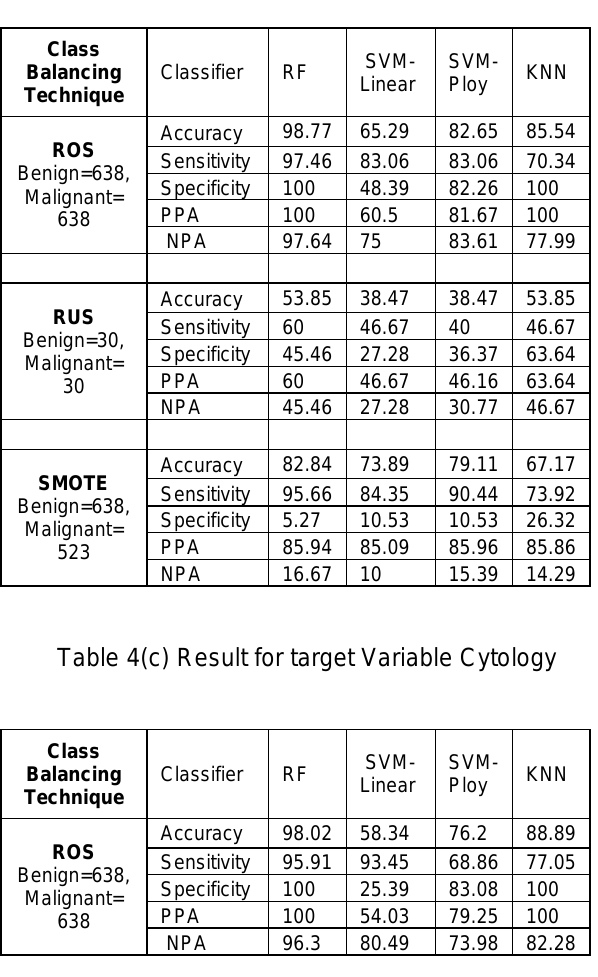
Table 4(b) Result for target Variable Schiller